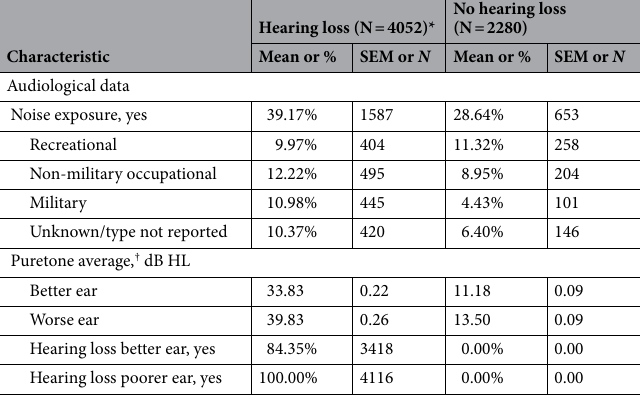
Table 2. Audiological characteristics by hearing status. dB HL decibels hearing level, SEM standard error of the mean. *Defined as PTA 0.5,1,2,4 > 20 dB HL in the worse ear. † Defined as average threshold at 0.5, 1, 2, 4 kHz.